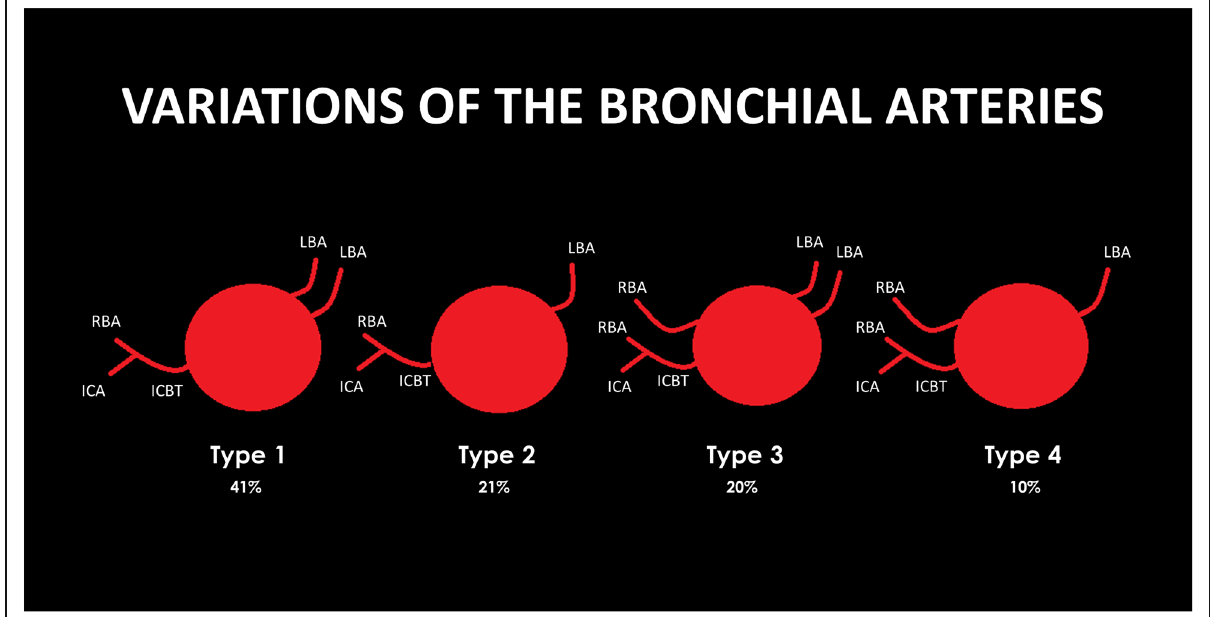
Fig. 2 Variations of the bronchial arteries. Bronchial arteries may have a great variability in terms of number. The most common patterns are two left and one right bronchial artery (type 1, most common), one artery in each side (type 2), two right and two left bronchial arteries (type 3), and two right and one left bronchial artery (type 4). Usually, the right bronchial artery originates from an intercostal-bronchial trunk (ICBT). RBA, right bronchial artery; LBA, left bronchial artery; ICBT, intercostal-bronchial trunk; ICA, intercostal artery